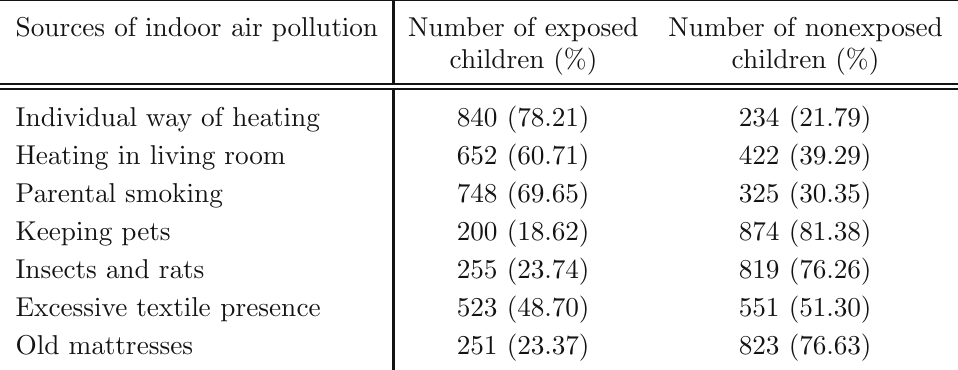
Table 3 Children’s exposure to different sources of indoor air